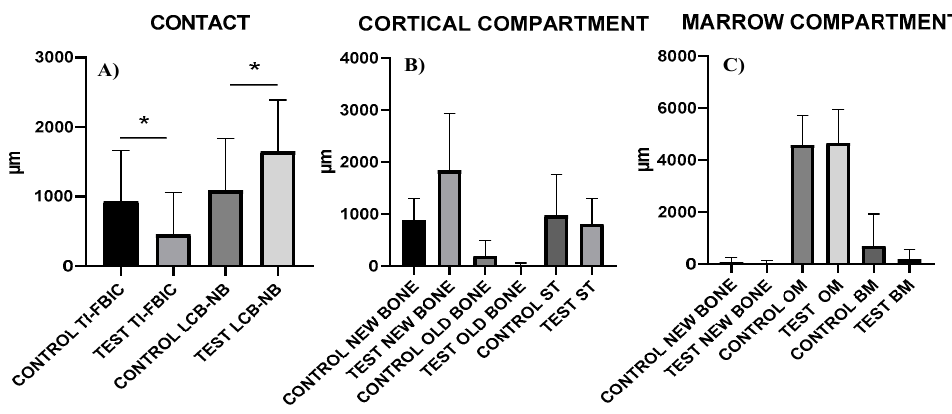
Figure 6. ( A ) Bar graph represents means and standard deviations of distribution of the Bone contact with the Implant surface; ( B ) Peri-implant tissues distribution at the level of the Cortical Compartment; ( C ) Peri-implant tissues distribution at the level of the Marrow Compartment (* p < 0.05). Table 1. Bone tissue in contact with the implant surface, in the cortical portion.